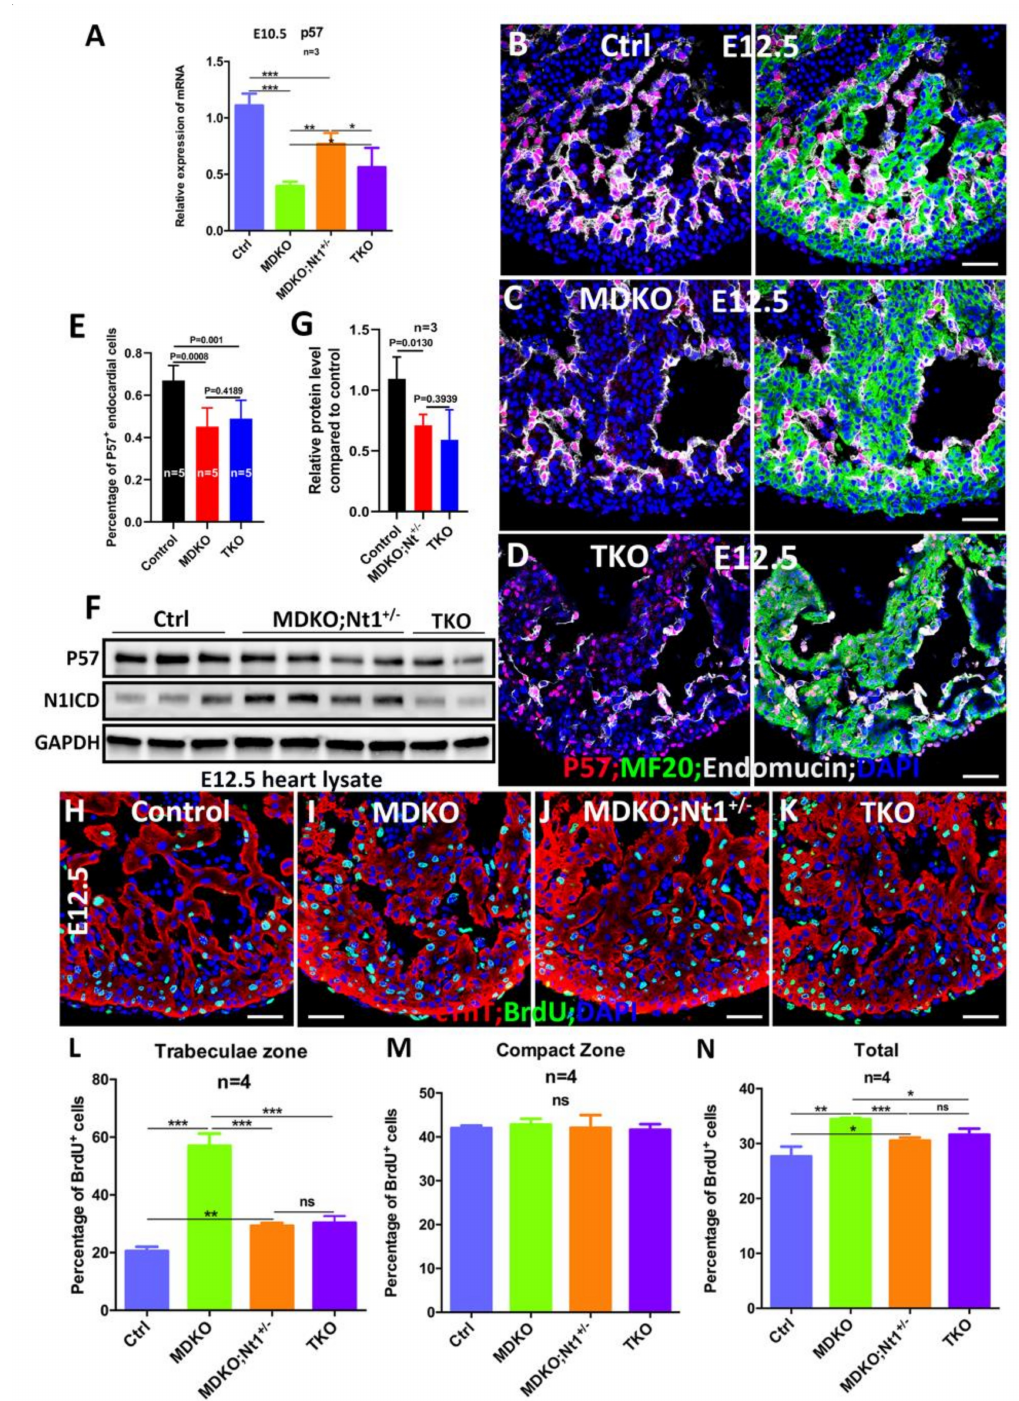
Figure 6. NFPs regulate p57 partially through Notch1. ( A ) P57 is downregulated in MDKO, and the abnormal expression of p57 was partially corrected in TKO based on Q-PCR. ( B ) P57 was mainly expressed in endocardial cells at E12.5. ( C – E ) The expression of p57 in MDKO and TKO was reduced compared with control. ( F – G ) The p57 expression was reduced in both MDKO; Nt1 +/ − and TKO based on western blot. ( H – N ) BrdU pulse labeling showed that cardiomyocyte proliferation increased in MDKO trabecular zone ( I , L ) compared with control ( H , L ). Cardiomyocytes proliferation rate in MDKO; Nt1 +/ − and TKO trabecular zone decreased significantly compared to that in MDKO, but is still higher than that in control ( J – L ). Compact zone cardiomyocytes proliferation rate among four types of hearts didn’t show a significant difference ( H – K , M ). * 0.01 < p < 0.05, ** 0.001 < p < 0.01, *** p < 0.001. ns, not significant. Scale bars: 100 µ